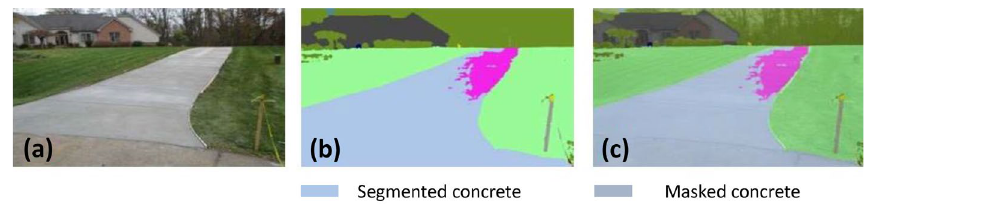
Figure 11. Offline results: concrete.